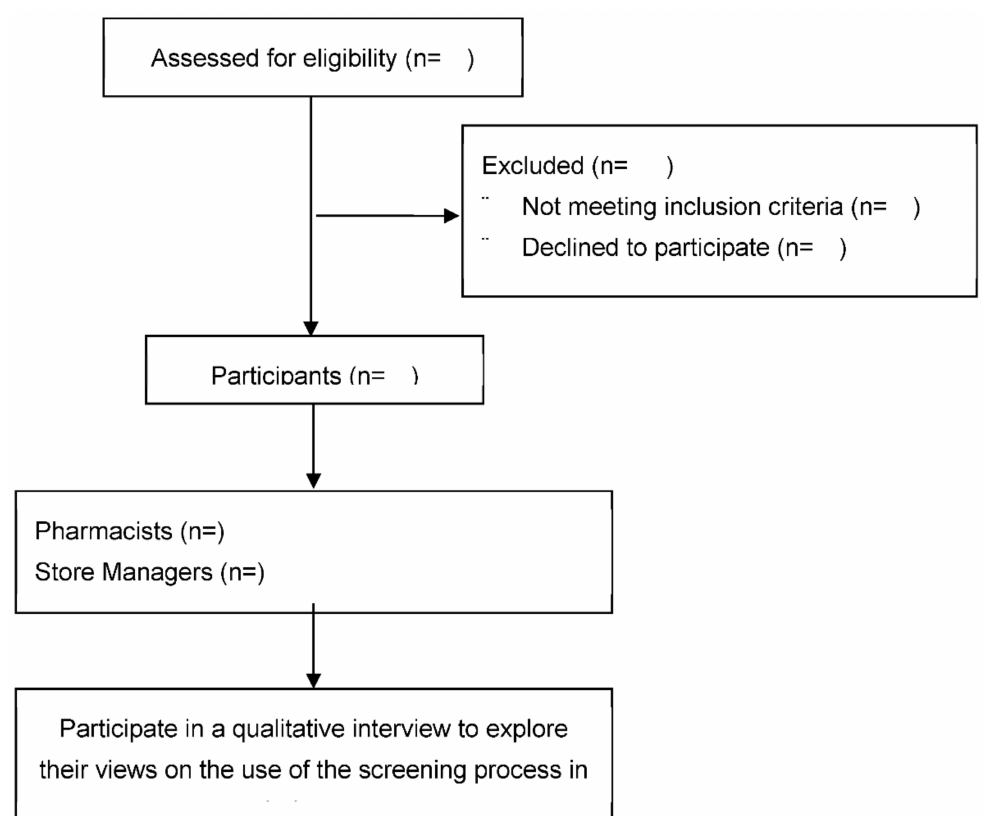
Figure 5. Phase 2 (Qualitative) procedure to follow when conducting semi-structured interviews exploring the views of supermarket-based pharmacists and store managers around the use of sensor technology to detect atrial fibrillation (AF) when embedded in the handles of supermarket